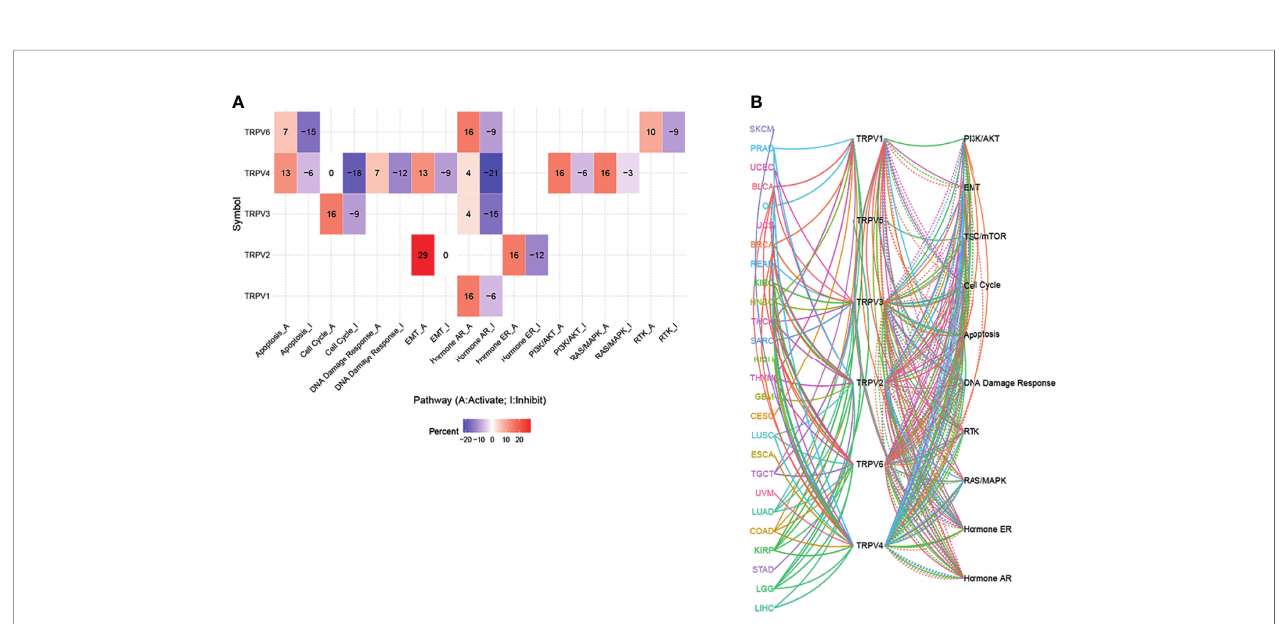
FIGURE 6 | The pathway activity network between TRPV channels. (A) The combined percentage of TRPV regulator genes in fl uencing pathway activity. (B) The line represents the connection between different pathways, where solid lines of the connecting pathways represent activation and dotted lines of the connecting pathways represent inhibition. The colors of the lines represent different types of